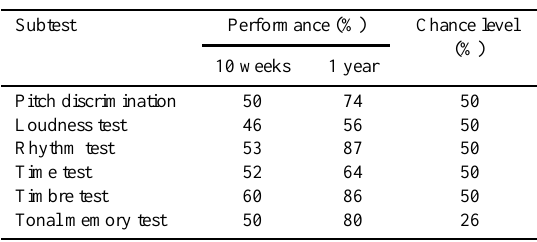
Table 2 Seashore Test